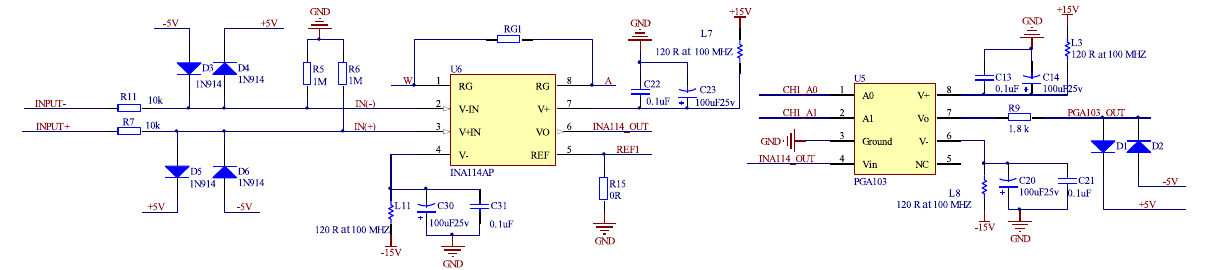
Figure 2. INA114 instrument amplifier and programmable gain amplifier circuit.